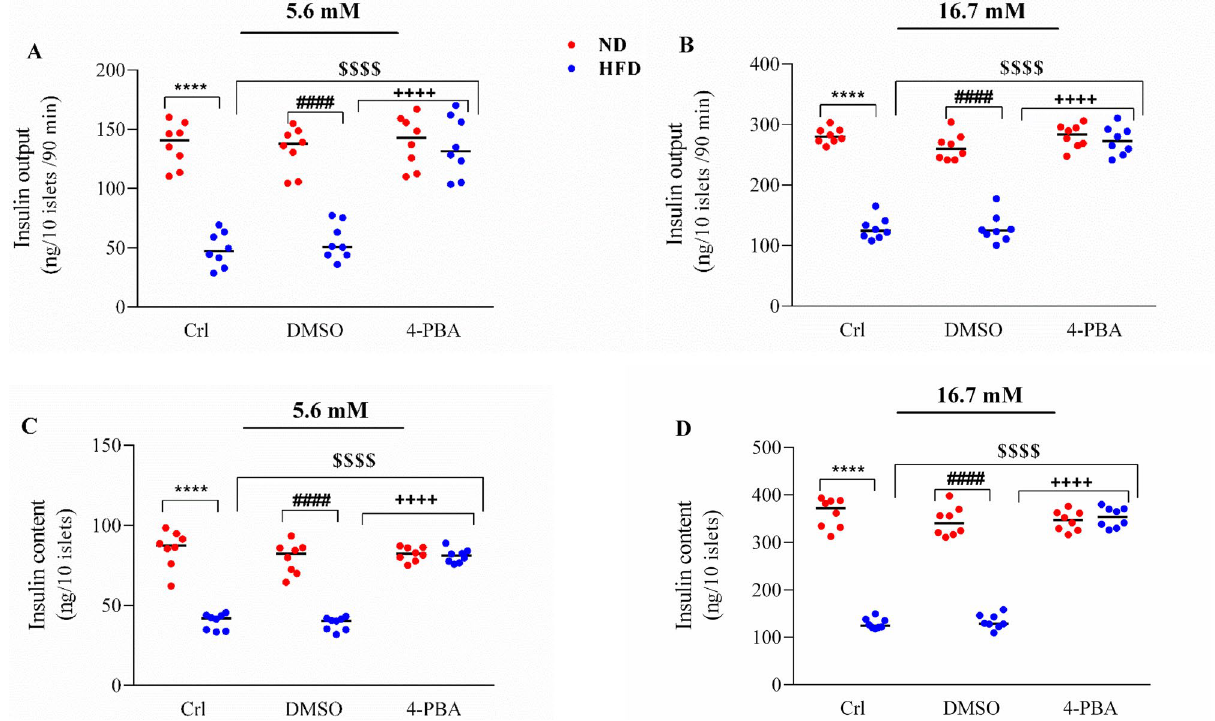
Figure 5. Effect of high-fat diet and/or 4-PBA on the pancreatic isolated islets’ ( A , B ) insulin output and ( C , D ) insulin content in the presence of 5.6 and 16.7 mM glucose concentrations, respectively. Each point represents the mean ± SEM (4 rats/group). ****p < 0.0001 versus control of ND group, #### p < 0.0001 versus ND + DMSO group, $$$$ p < 0.0001 versus control of HFD group, ++++ p < 0.0001 versus HFD + DMSO group. ND Normal